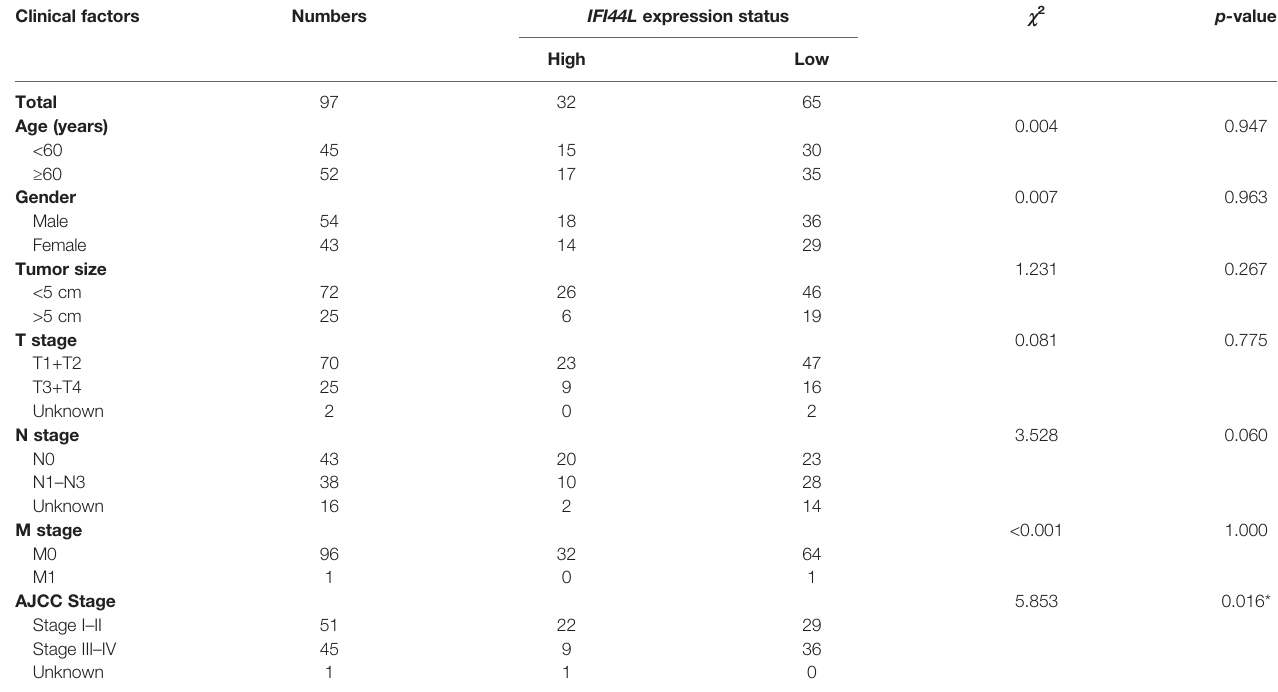
TABLE 2 | Association between clinical factors and IFI44L expression among NSCLC patients in the TMA cohort. Clinical